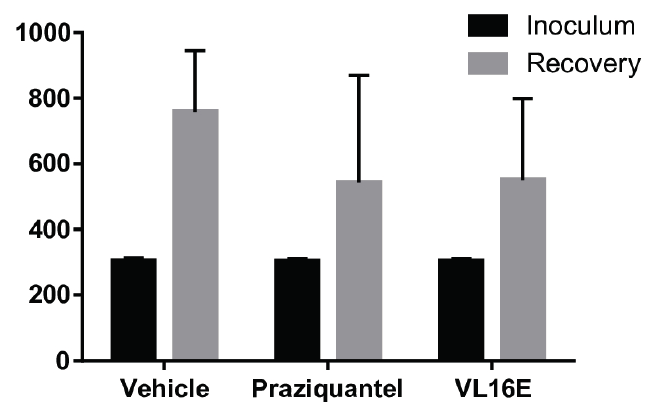
Figure 7. VL16E reduces infection burden of M. vogae infection in mice. Three groups of eight mice each were infected with approximately 300 M. vogae tetrathyridium larvae by intraperitoneal injection and treated by gavage at days 14, 15 and 16 after infection with vehicle (4% dimethyl sulfoxide in PBS, negative control group), praziquantel (positive control group) and VL16E (oxadiazole N -oxide 3,4-bis(phenylsulfonyl)-1,2,5-oxadiazole N 2 -oxide). At day 17 mice were sacrificed and the recovered larvae counted. Results are expressed as mean larval count and standard deviations. The increase in tetrathyridium count (recovery vs. inoculum) wss statistically significant in the vehicle group but not in treated groups (either praziquantel or